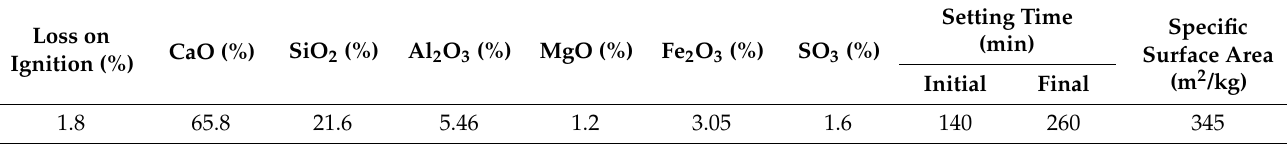
Table 1. Properties of